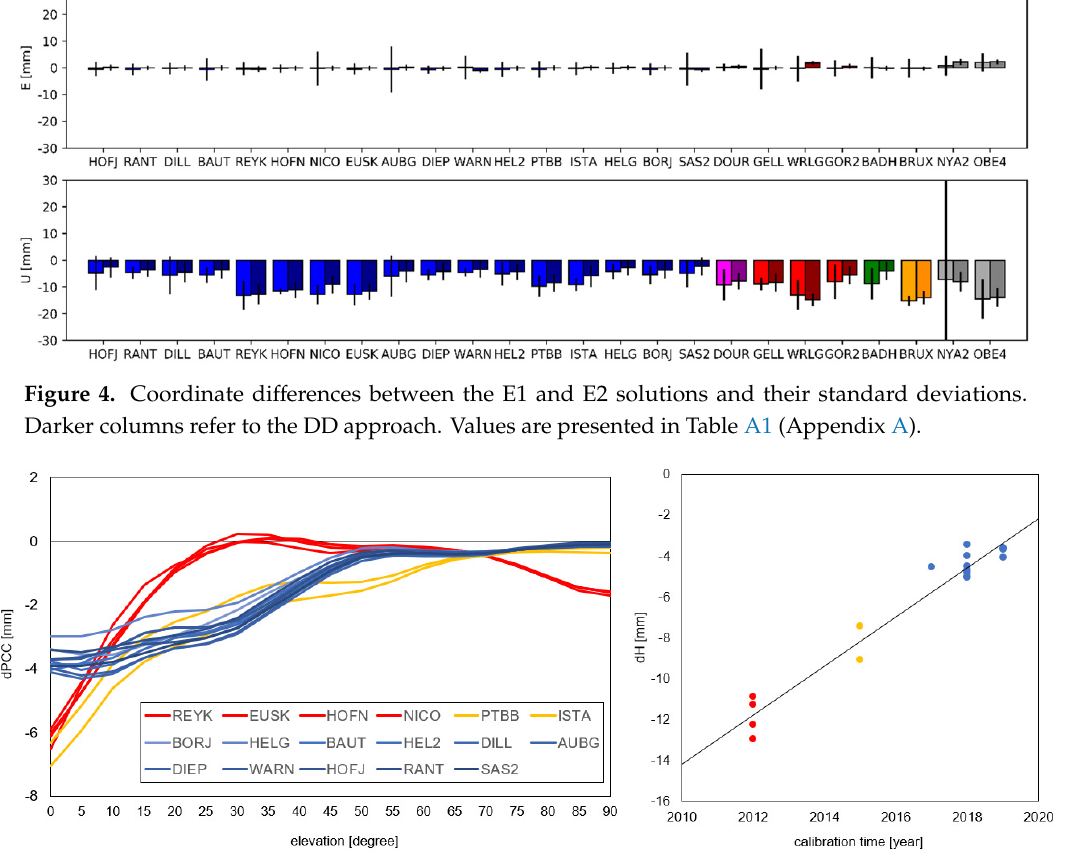
Figure 5. Differences in PCV between the E05 and G02 values for the LEIAR25.R4 LEIT antennas (on the left) and the resulting height differences for the DD approach (E2–E1).